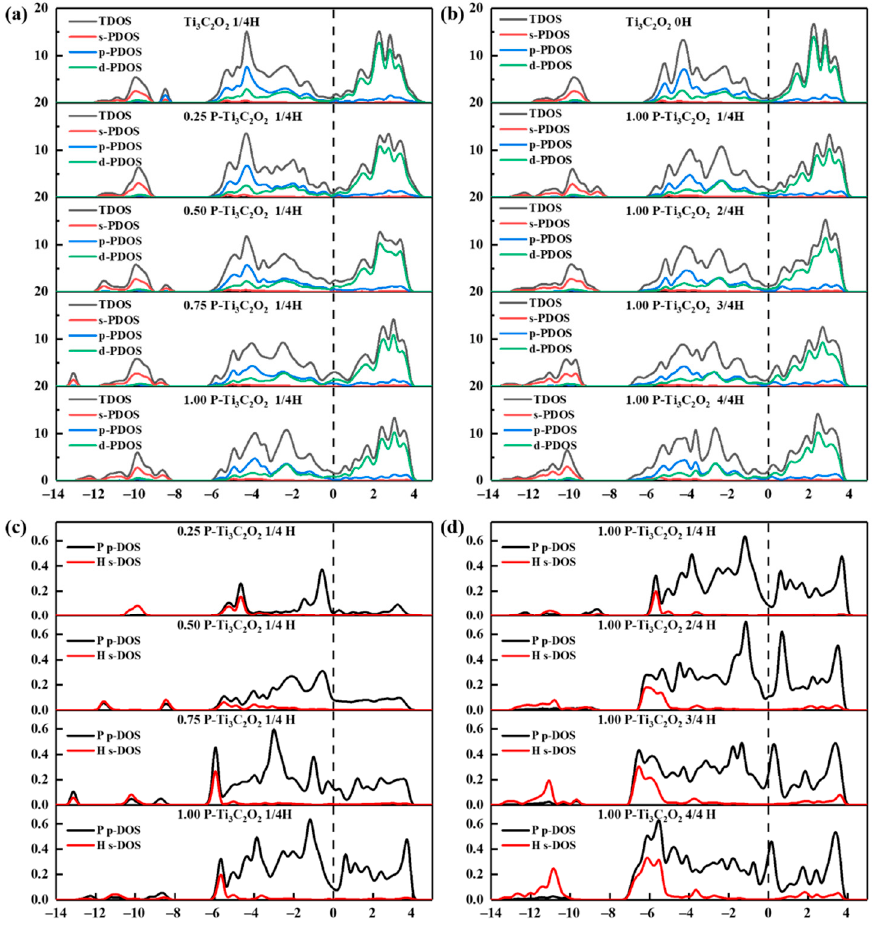
Figure 7. The total density of states (TDOS) and projected density of states (PDOS) of Ti 3 C 2 O 2 and Ti 3 C 2 O 2 doped with different concentrations of P elements and absorbed different concentrations H elements. ( a , c ) are TDOS and PDOS of Ti 3 C 2 O 2 , 0.25 P-Ti 3 C 2 O 2 , 0.50 P-Ti 3 C 2 O 2 , 0.75 P-Ti 3 C 2 O 2 and 1.00 P-Ti 3 C 2 O 2 absorbed 1/4H, respectively; ( b , d ) are TDOS and PDOS of Ti 3 C 2 O 2 , and 1.00 P-Ti 3 C 2 O 2 absorbed 1/4H, 2/4H, 3/4H and 4/4H, respectively.